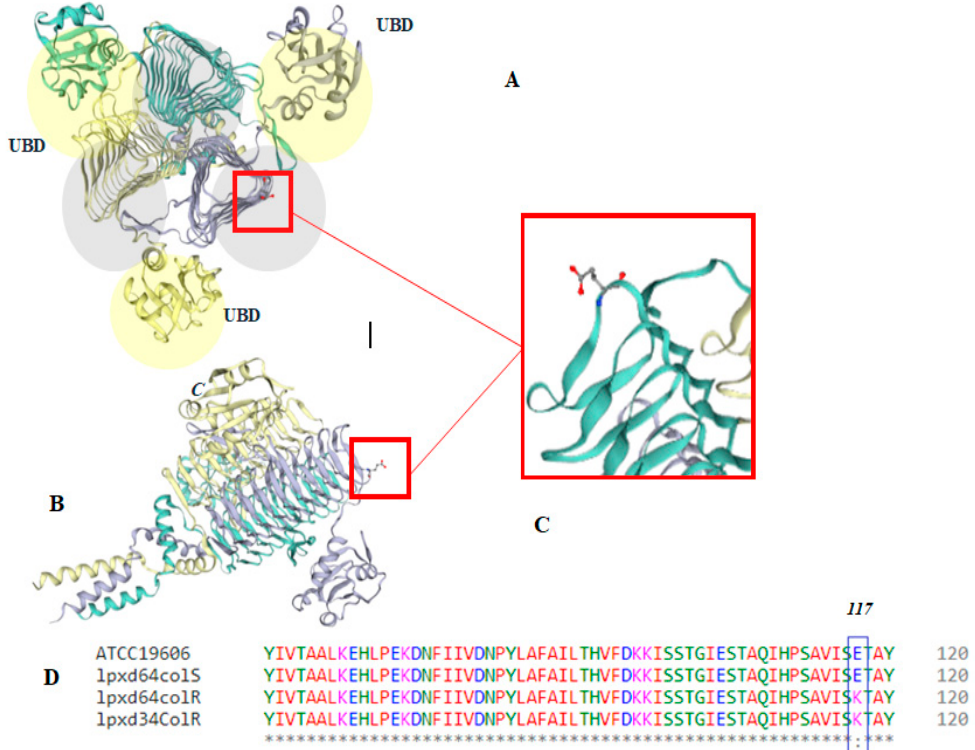
Figure 2. Predicted 3D model structure of MS64Col-R LpxD protein. ( A ) Orthogonal view of the trimer, showing three chains where the lipid-binding domain (LBD) is colored in grey shades. ( B ) Side view of the trimer. ( C ) Amino acid substitution position (117). ( D ) Amino acid sequence alignments of a part of the LpxD protein of the colistin-sensitive reference strain (ATCC19606), colistin-sensitive clinical isolate (64colR), colistin-resistant laboratory-induced isolate (64colR), and colistin-resistant clinical isolate (34colR), generated by online Clustal W–Model server. UBD: uridine-binding domain.